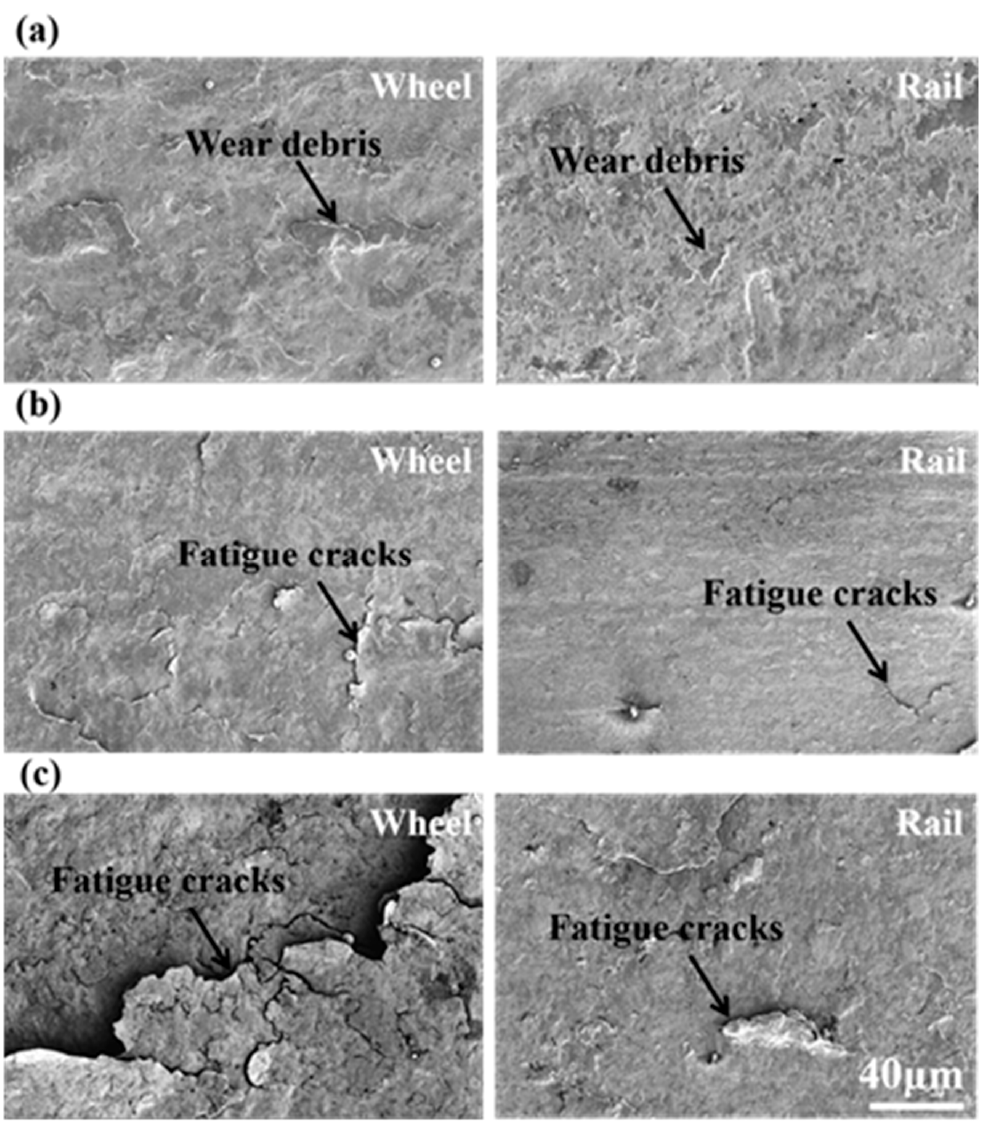
Figure 11. The surface wear morphology of wheel and rail samples under different contact stress conditions: ( a ) 700 MPa; ( b ) 900 MPa and ( c ) 1200 MPa.